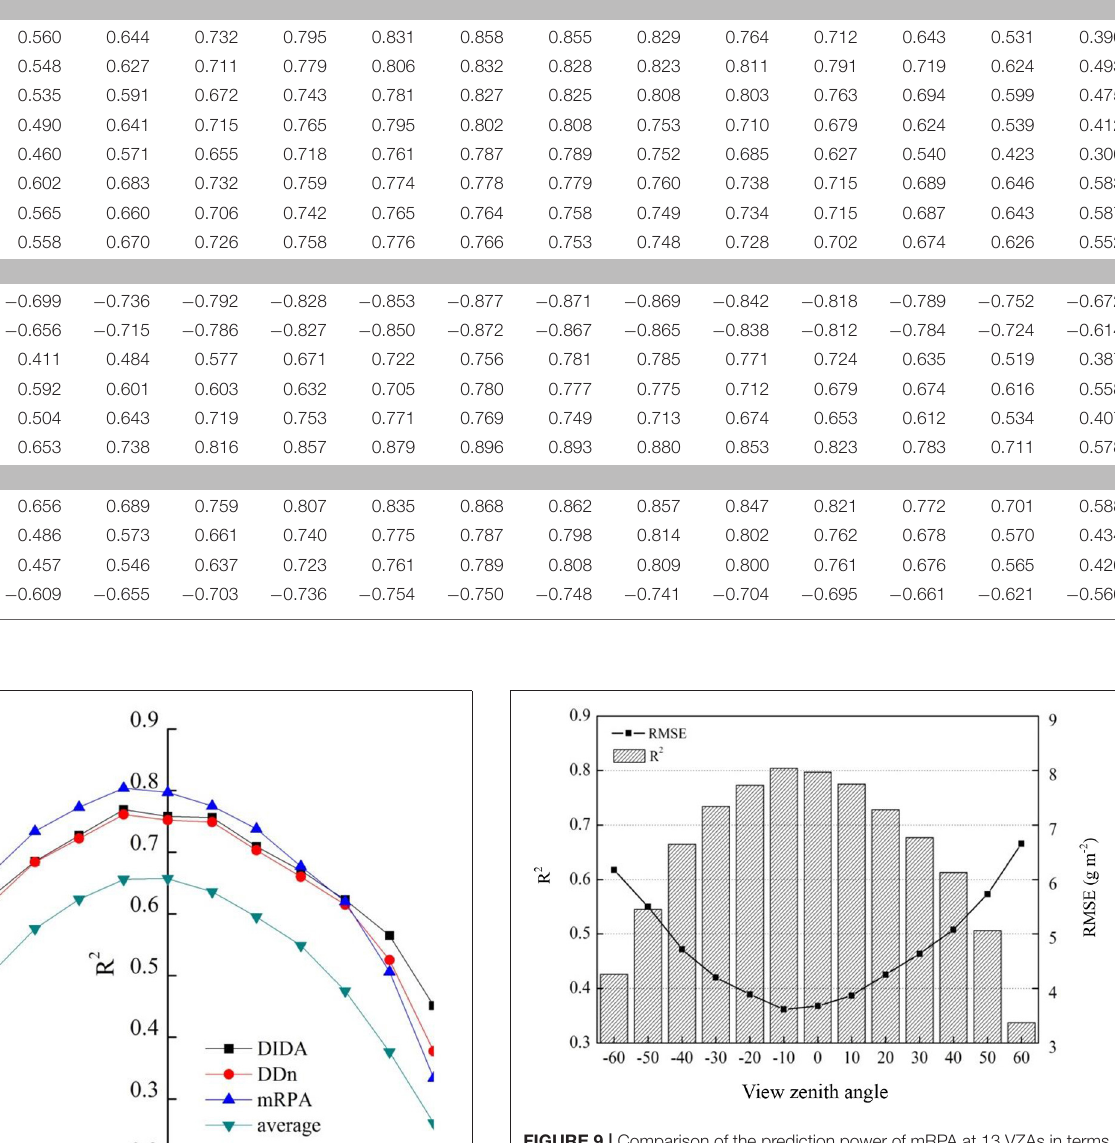
FIGURE 9 | Comparison of the prediction power of mRPA at 13 VZAs in terms of aerial N uptake ( n = 155, p 0.001 = 0.262).